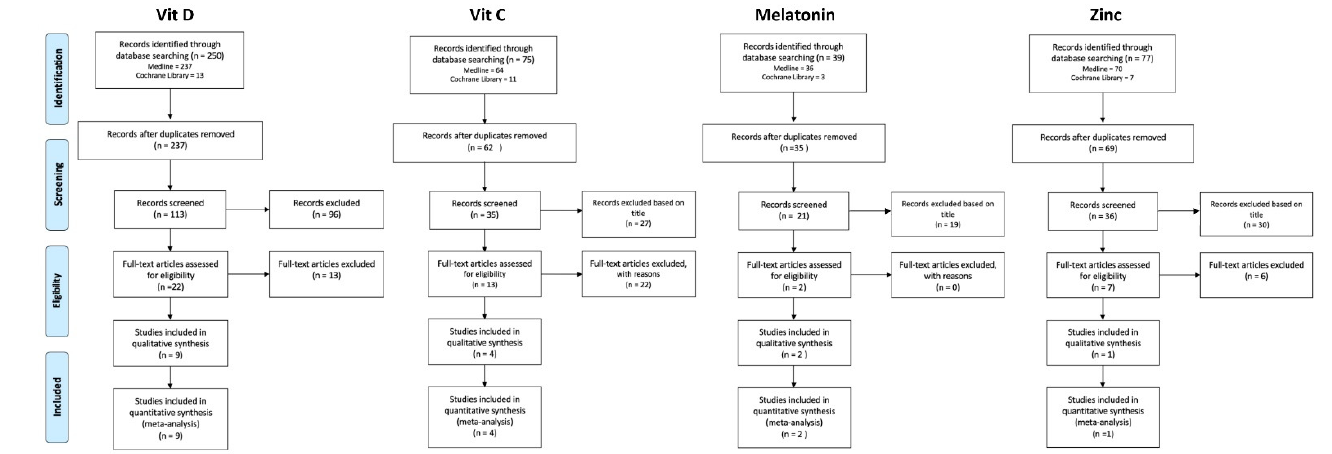
Figure 1. Flow diagram of the study selection process.